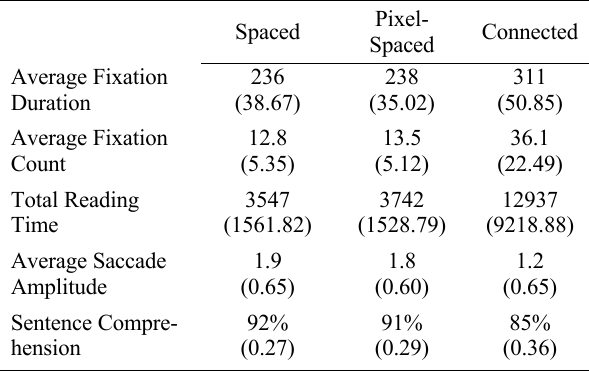
Table 3. Descriptive Statistics for the Dependent Measures